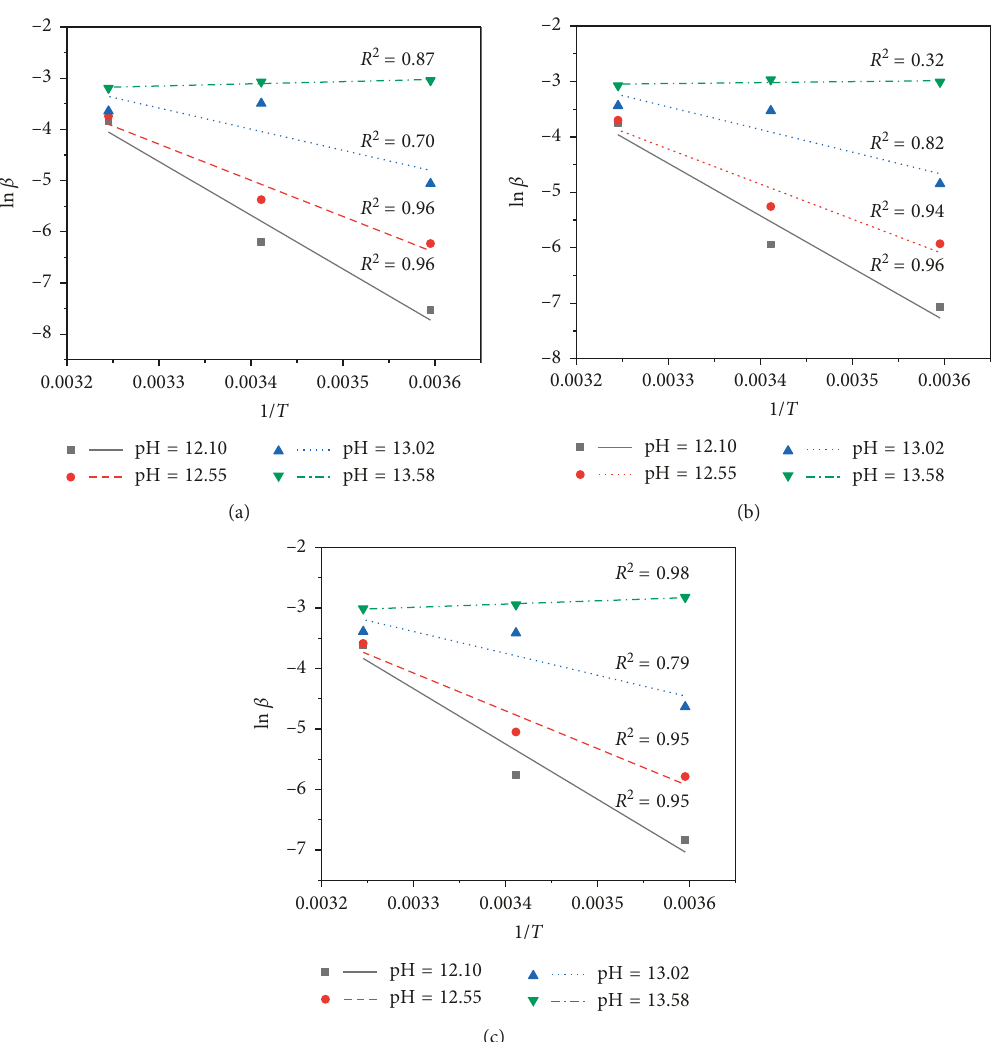
Figure 5: Effect of curing temperature on the hydration rate β at different w/s ratios for 7days: (a) w/s